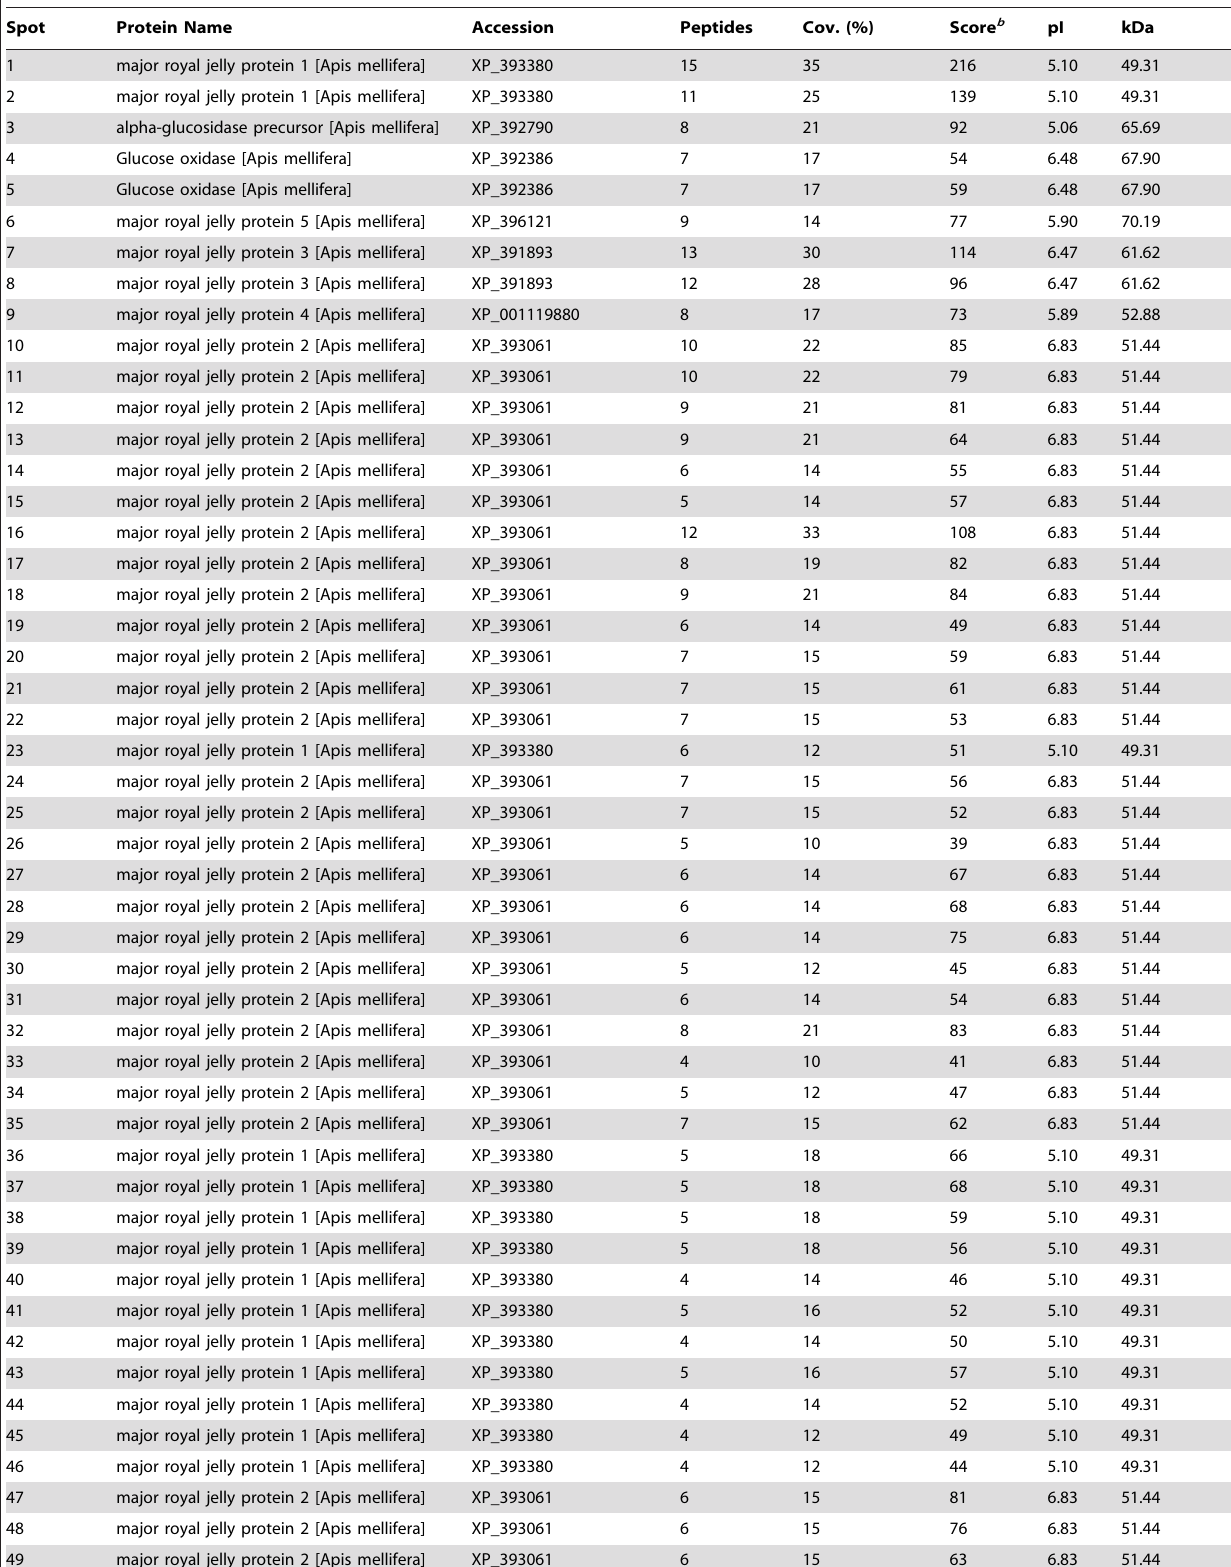
Table 5. Protein identification in the honey sulla MT1 extract a